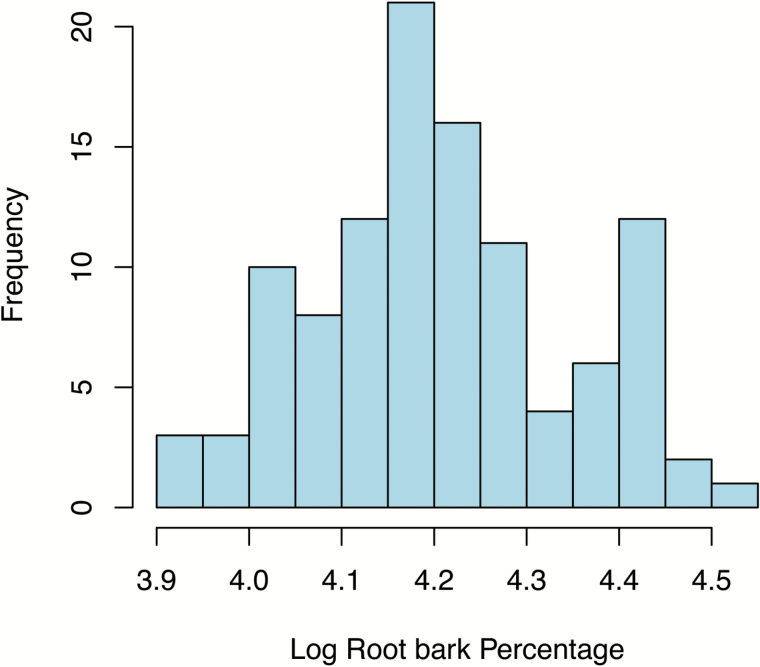
Histogram of phenotypic distribution of log-transformed root bark percentage data for the M432 mapping population.